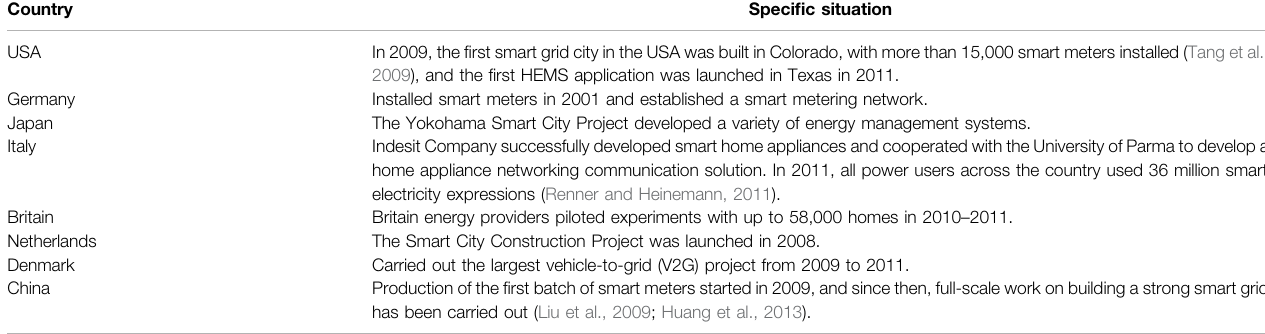
TABLE 1 | Overview of the development of the HEMS.